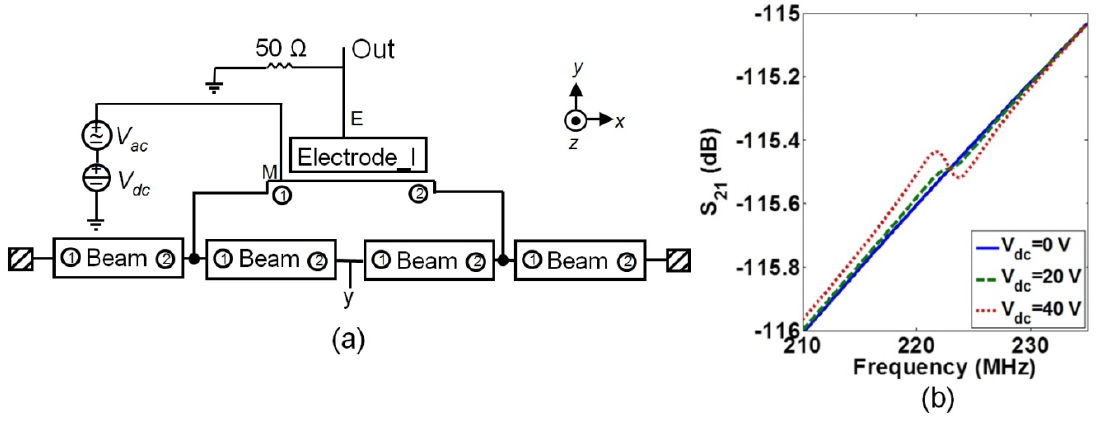
signal for different V 21 dc